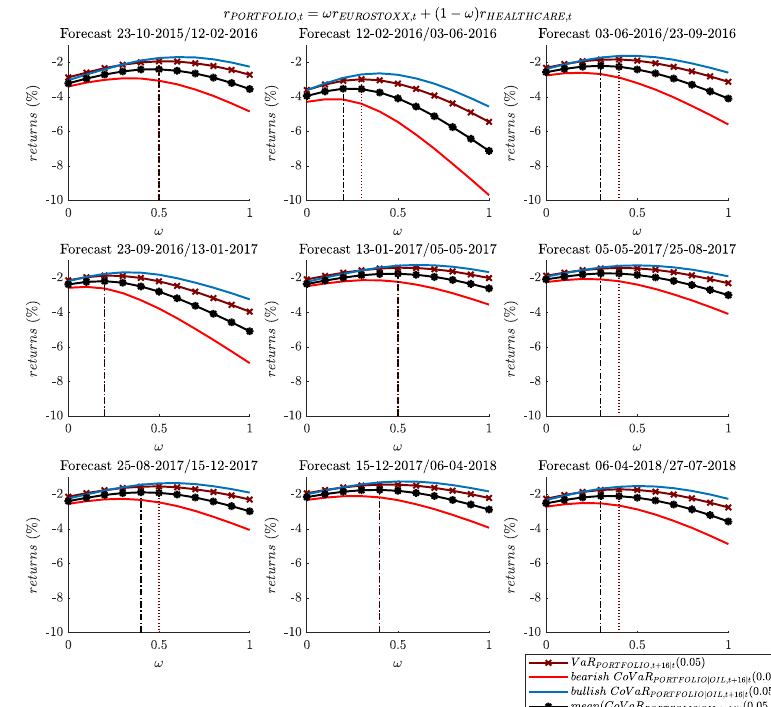
Figure 10: Forecast exercise : building a portfolio without tail dependence using Eurostoxx and health sector